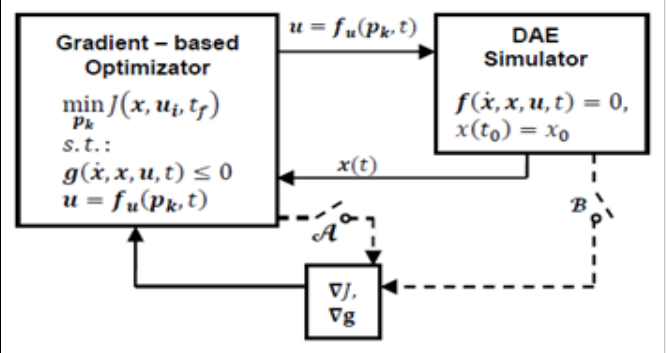
Figure 1: Diagram of the direct sequential